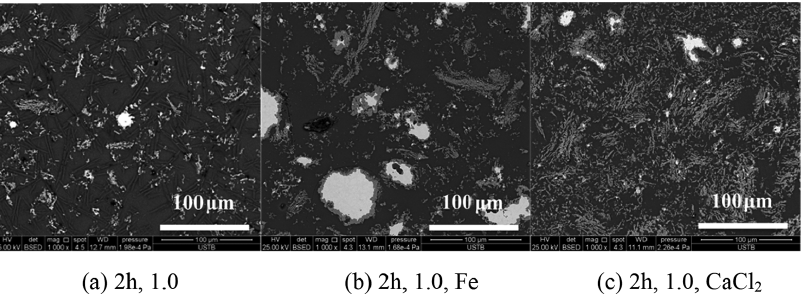
Figure 20: BSED images of the samples reduced with carbon ratio of 1.0, 2 h, at 1,873 K for different additives: (a) none; (b) 5 wt% Fe; (c) 5 wt% CaCl 2